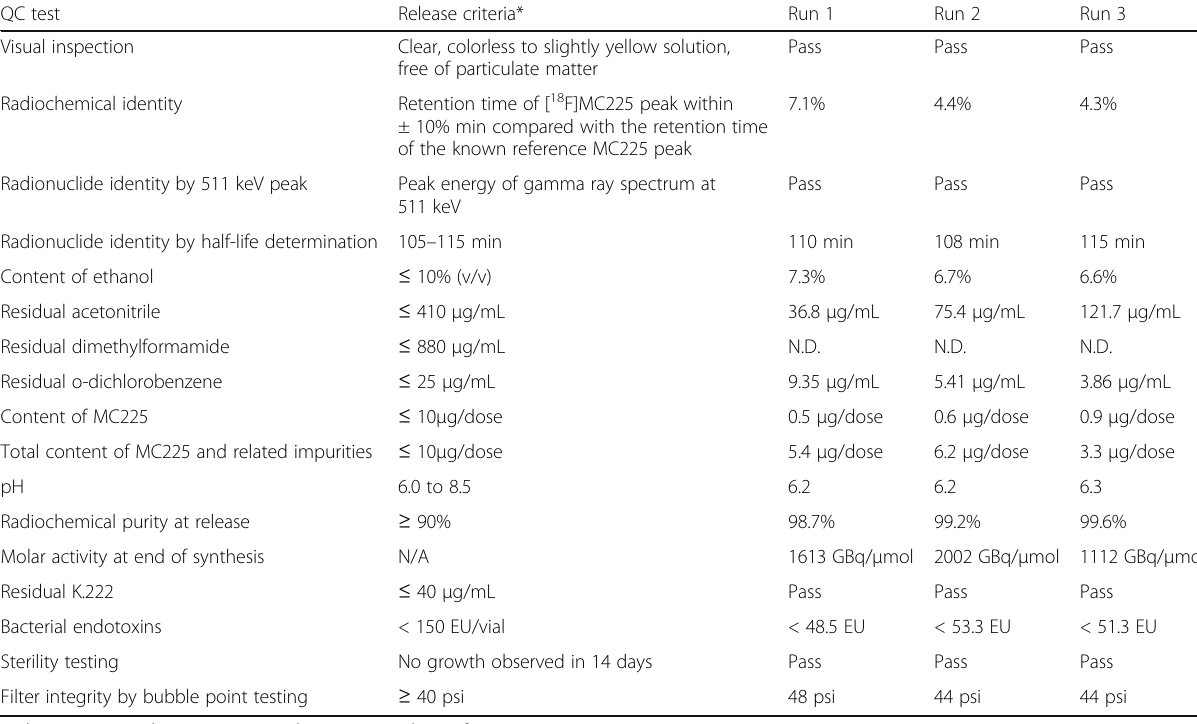
Table 2 Product release specifications and validation test results of [ 18 F]MC225 QC test